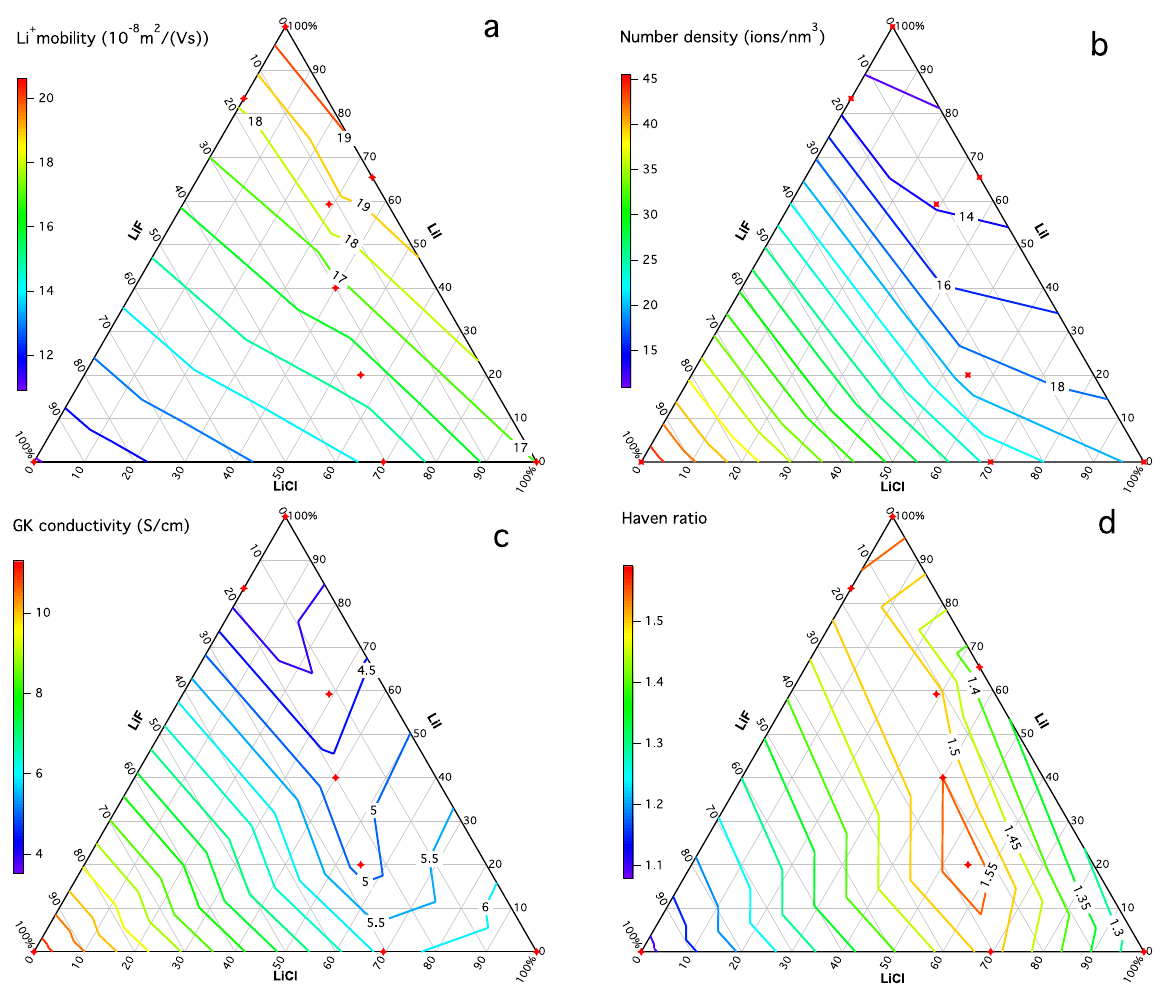
Fig. 2 Composition-dependent properties for LiF α Cl β I γ at 1200K. Ternary diagram of a Li + electrical mobility in 10 − 8 m 2 V − 1 s − 1 , b Li + number density in ions per nm 3 , c GK conductivity in S cm − 1 , and d Haven ratio = σ NE / σ GK for salts containing LiF, LiCl, and/or LiI at 1200 K. σ NE was calculated using the diffusion coef fi cients that were determined by means of the velocity autocorrelation function (vac). A higher number of the Haven ratio indicates more ion cross-correlations (it does not necessarily indicate more ion association) 6 . Calculated points are shown as red diamonds; the contour lines are linearly